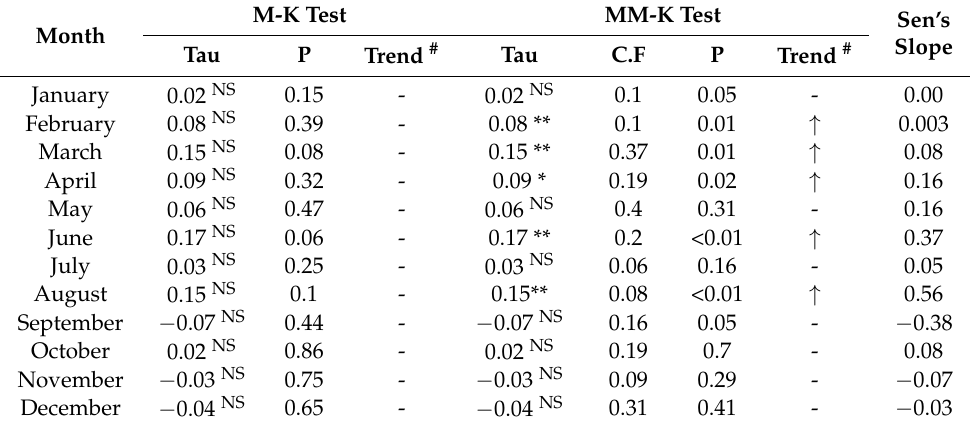
Table 3. Analysis of trends in monthly rainfall (1960–2019) in SIK. M-K Month